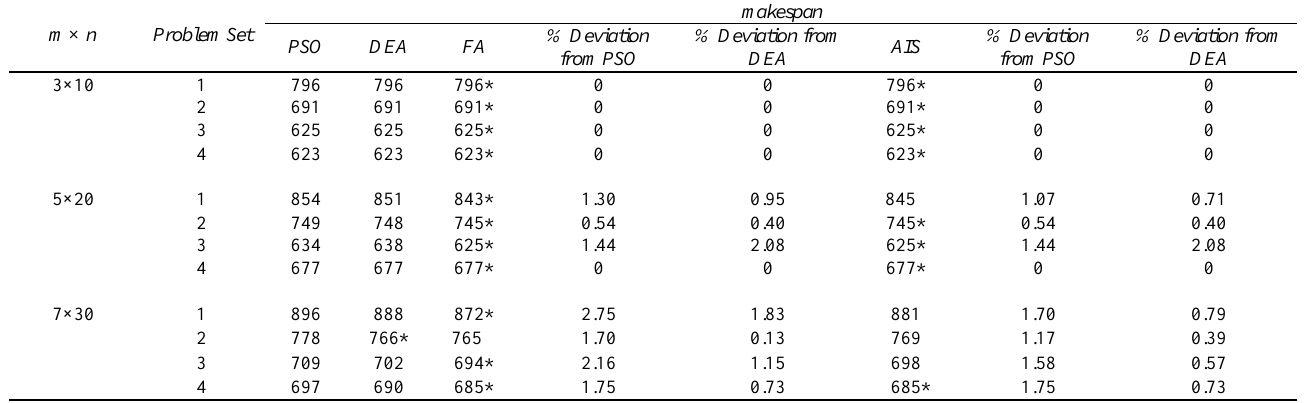
Table 8 – Comparison between FA, AIS, DEA and PSO for equal size sublots (makespan) 30